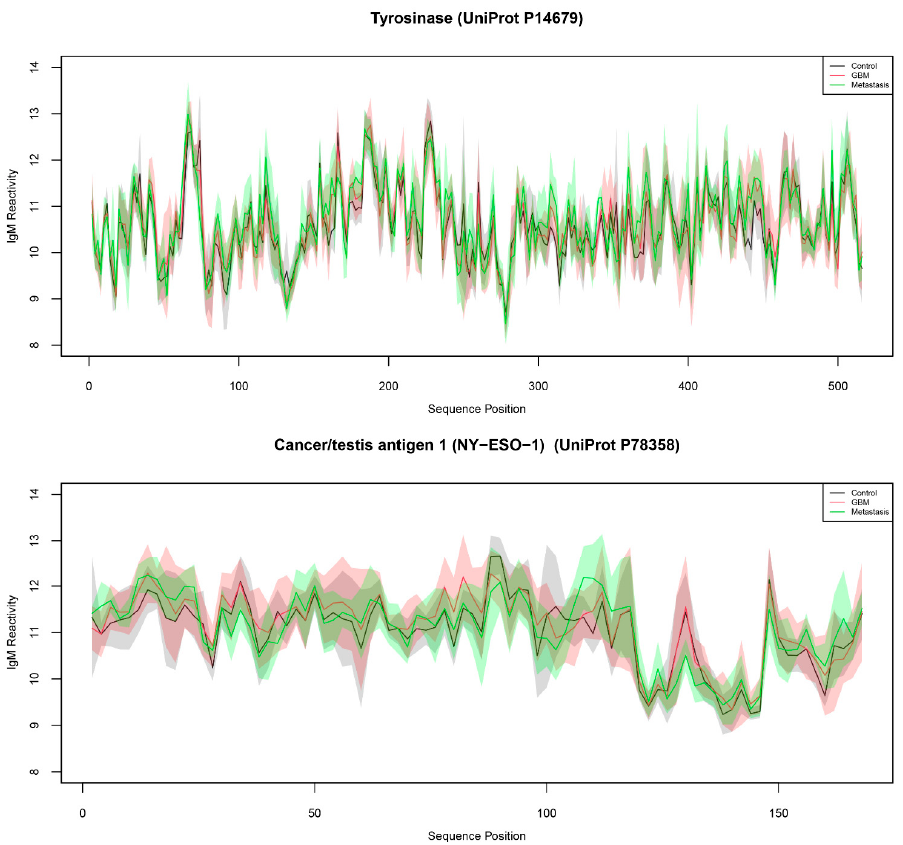
Figure 1. Mean and standard deviation of IgM reactivity from control (black line /grey shading), GBM (red), and metastases (green) patient groups to tyrosinase ( above ) and NY-ESO-1 ( below ). The shaded areas represent the respective standard deviation ranges.